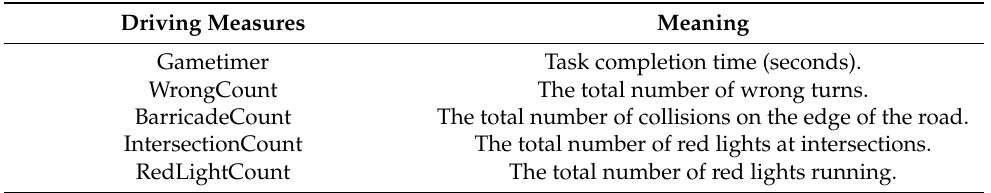
Table 1. Performance Features and their